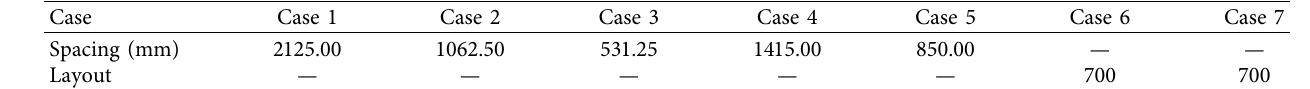
Figure 13: The first thirty natural frequencies for different numbers of shear studs. Table 1: Various cases to examine the role of the rib spacing in the structural